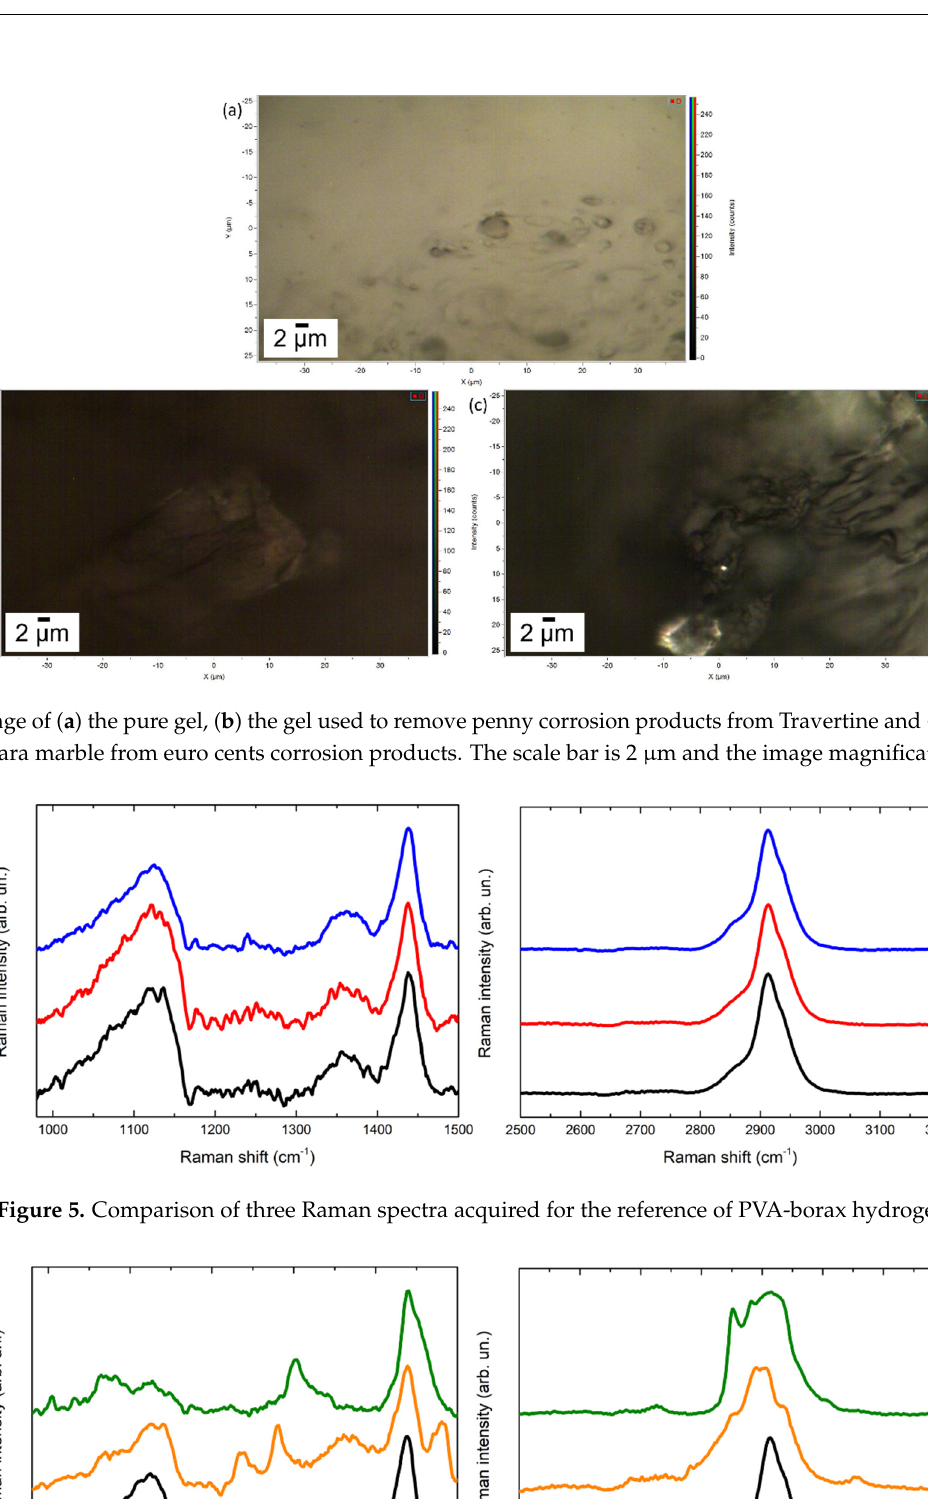
Figure 4. Image of ( a ) the pure gel, ( b ) the gel used to remove penny corrosion products from Trav- ertine and ( c ) the gel used to clean Carrara marble from euro cents corrosion products. The scale bar is 2 µm and the image magnification is 100×.